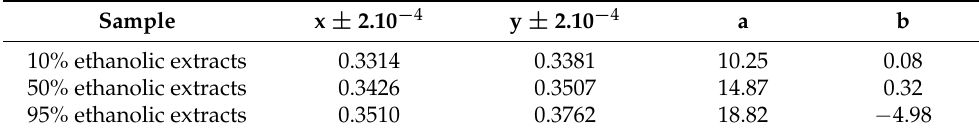
Table 2. Color parameters in two different colorimetric